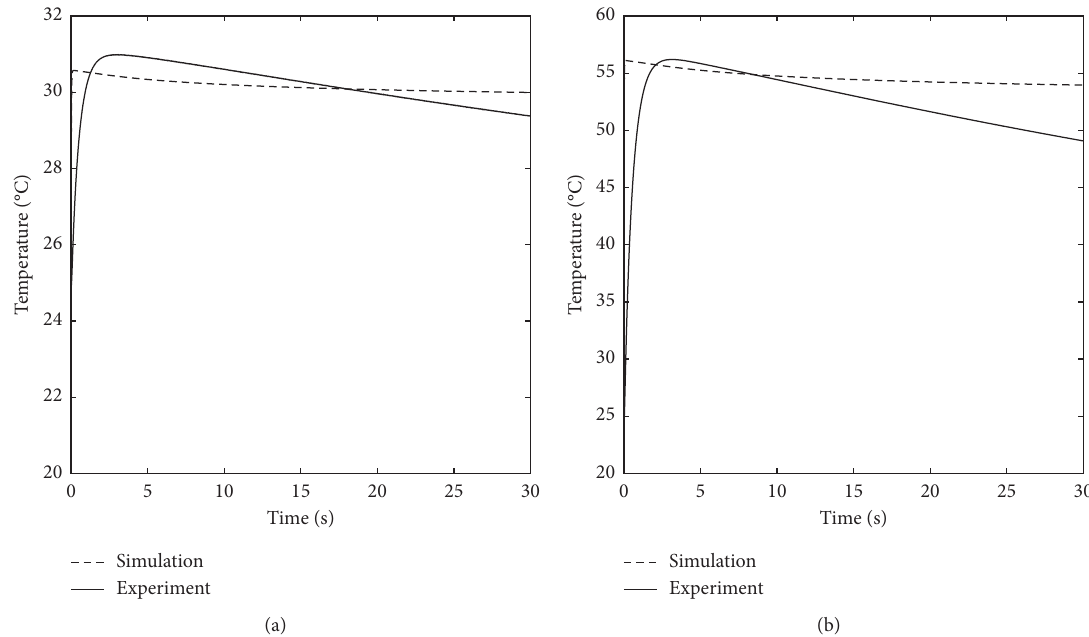
Figure 18: Thermal analysis results compared with experimental results for shot 128 and shot 132, probed on the surface of the second specimen at a length of 82.3mm.